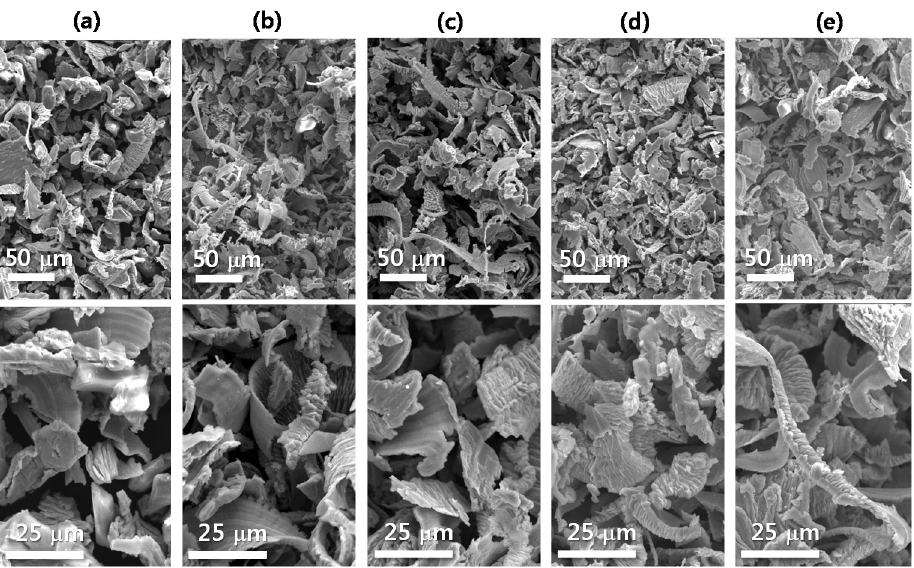
Figure 6. Metal chips resulting from grinding at 10,000 rpm (two magnifications):